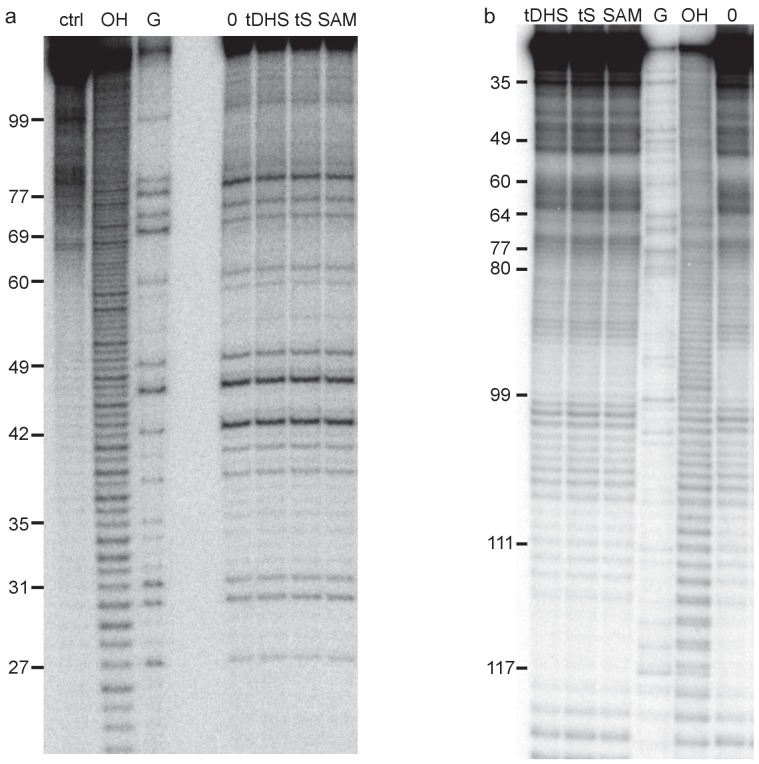
Structural probing of Were-1 in presence of tDHS, tS, and SAM by T1 nuclease digestion and in-line probing.(a) T1 digestion controls. Left lanes contain a control with no RNA, partial hydrolysis (OH), and RNase T1 digestion for sequence reference. Right lanes indicate no ligand (0), followed by Were-1 in the presence of 30 µM controls, as labeled above the gel image. (b) In-line probing of Were-1 with 30 µM controls, as labeled above the gel image, followed by RNase T1 digestion for sequence reference, partial hydrolysis (OH), and a no ligand control (0).